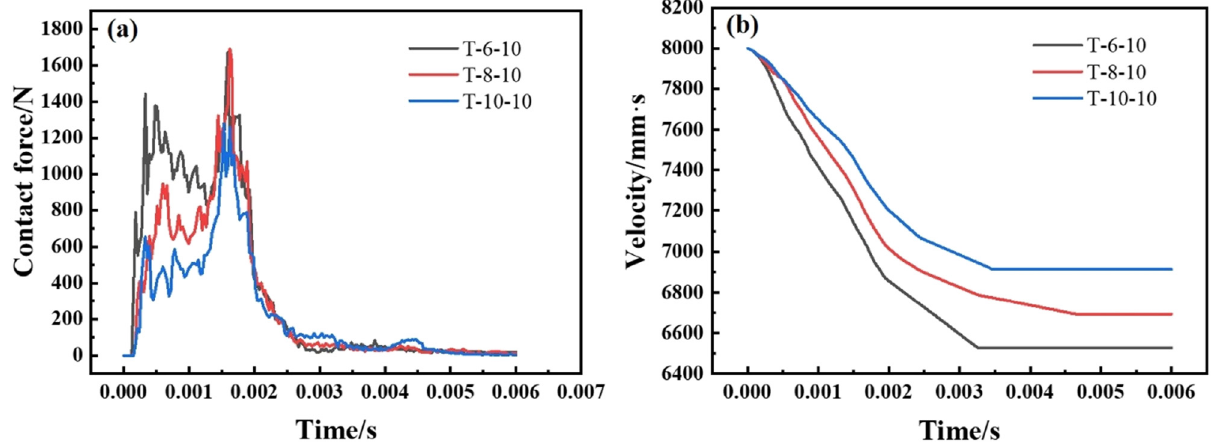
Figure 4: Comparison between contact force – time and velocity – time curves of T - 6 - 10, T - 8 - 10, and T - 10 - 10. ( a ) Contact force – time curves and ( b ) velocity – time curves.